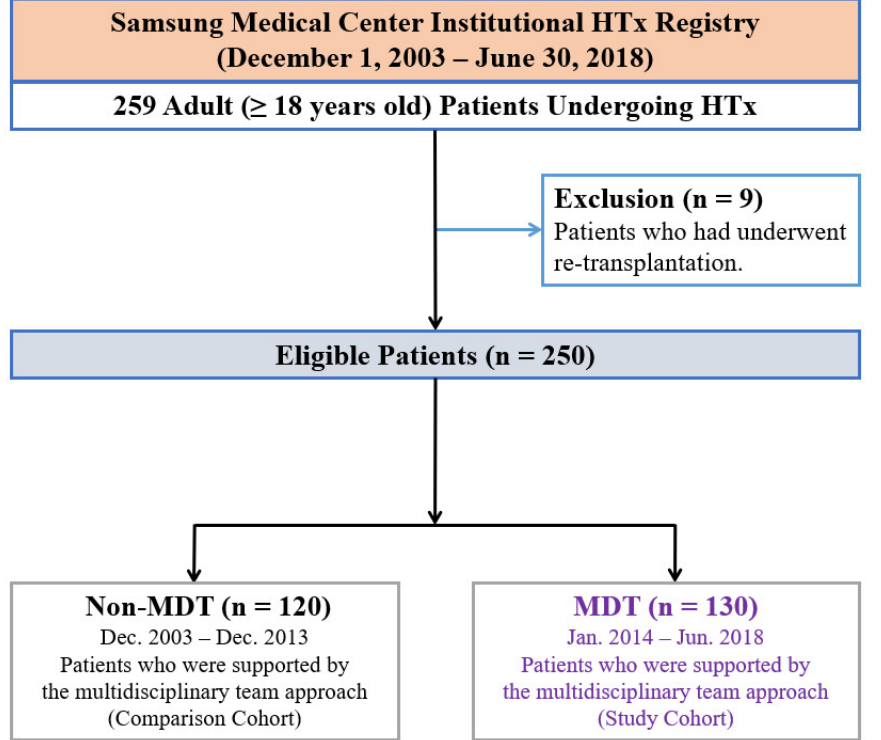
Figure 1. Flow diagram of patient recruitment. HTx, heart transplantation; MDT, multidisciplinary team.